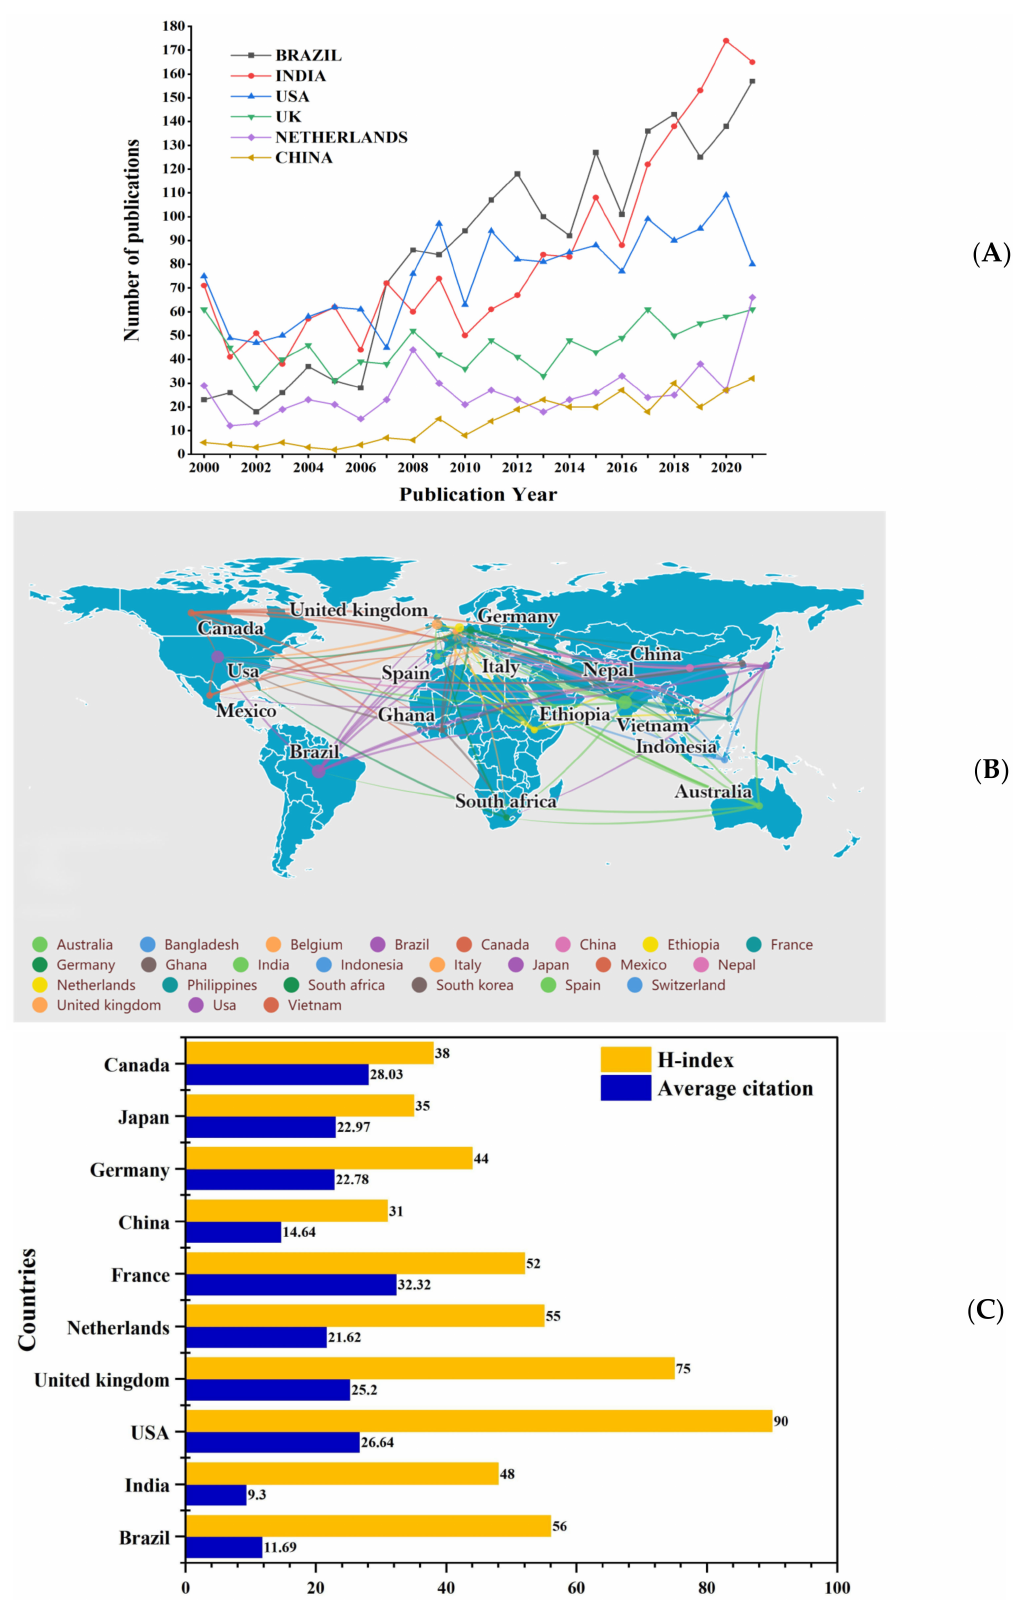
Figure 5. Cooperation between countries/regions in the field of leprosy (2000–2021). ( A ) The number of publications for the top 5 countries related to leprosy. ( B ) Map of inter-country cooperation on lep- rosy (2000–2021). ( C ) H-index and average citation rate per paper for the ten most productive